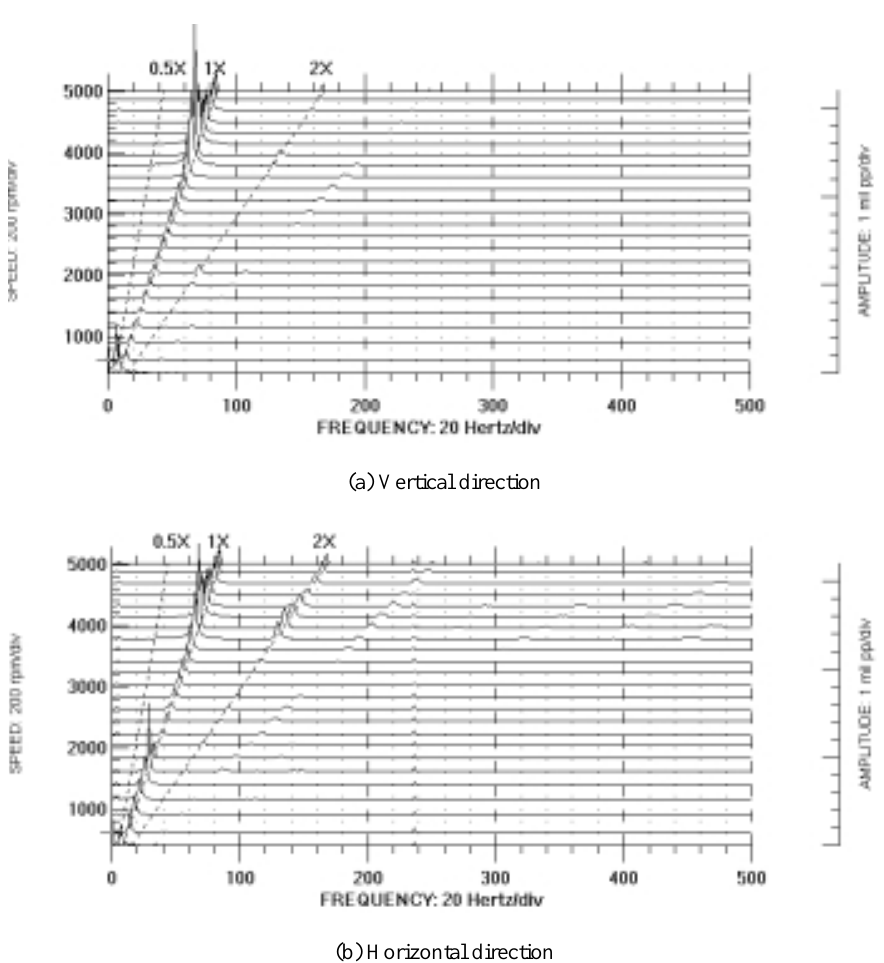
Fig. 3. Frequency cascades of the startup data for un-cracked shaft with 8 kg hanging side